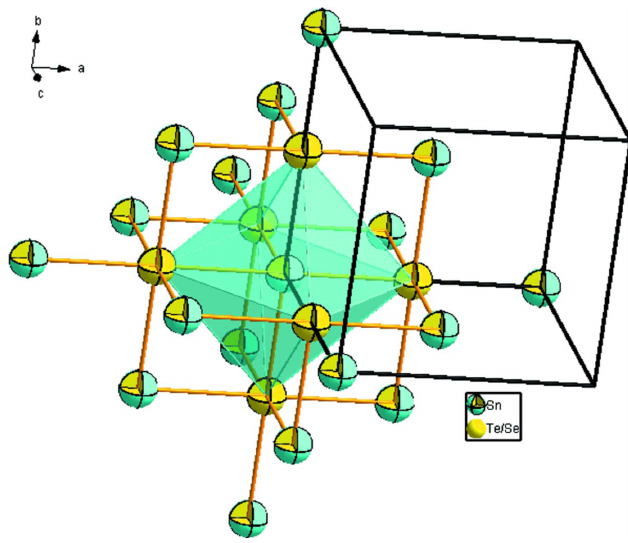
Figure 1 A view of the NaCl-type crystal structure of SnTe 0.73 (2) Se 0.27 (2) . Displacement ellipsoids are drawn at the 50% probability